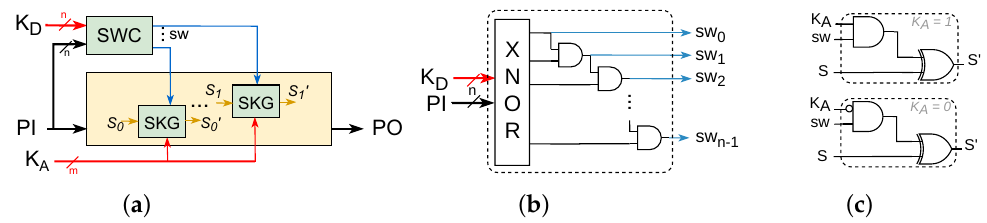
Figure 5. Original structure of SKG-Lock+ components: ( a ) general structure, ( b ) switch controller, ( c ) switchable